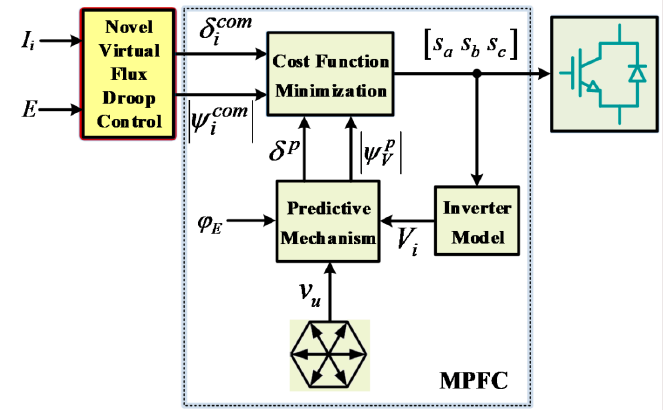
Figure 2. Structure of the proposed microgrid control